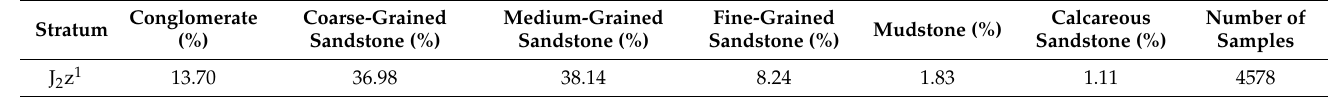
Table 2. Grain-size classification of sandstone in the Lower Member of Zhiluo